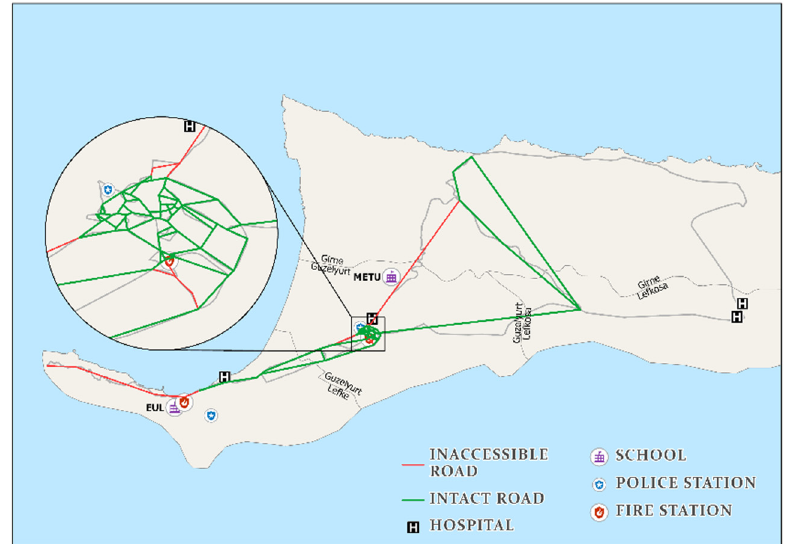
Figure 13. Scenario 2 transportation network.